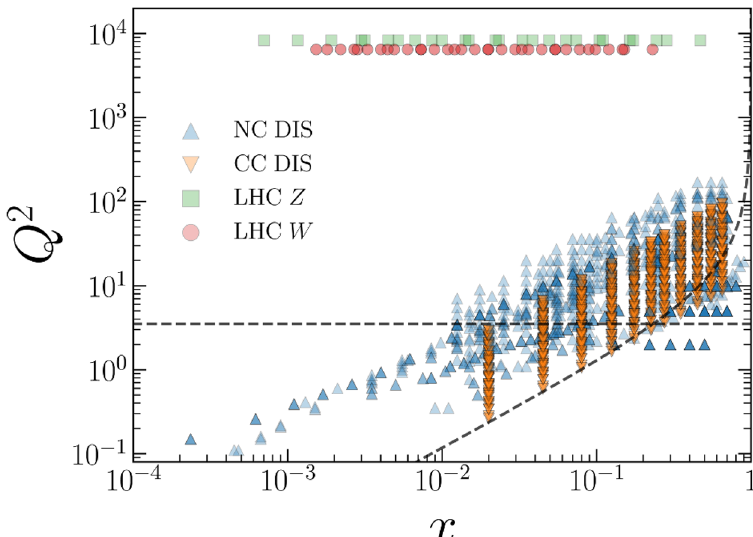
Figure 1 . Kinematical coverage in x and Q 2 of the data points included in the nNNPDF2.0 determination. The horizontal dashed and curved dashed lines correspond to Q 2 = 3 : 5 GeV 2 and W 2 = 12 : 5 GeV 2 , respectively, which are the kinematic cuts imposed in this analysis. For each LHC measurement, there are two values of x associated with leading order kinematics of proton-lead scattering being